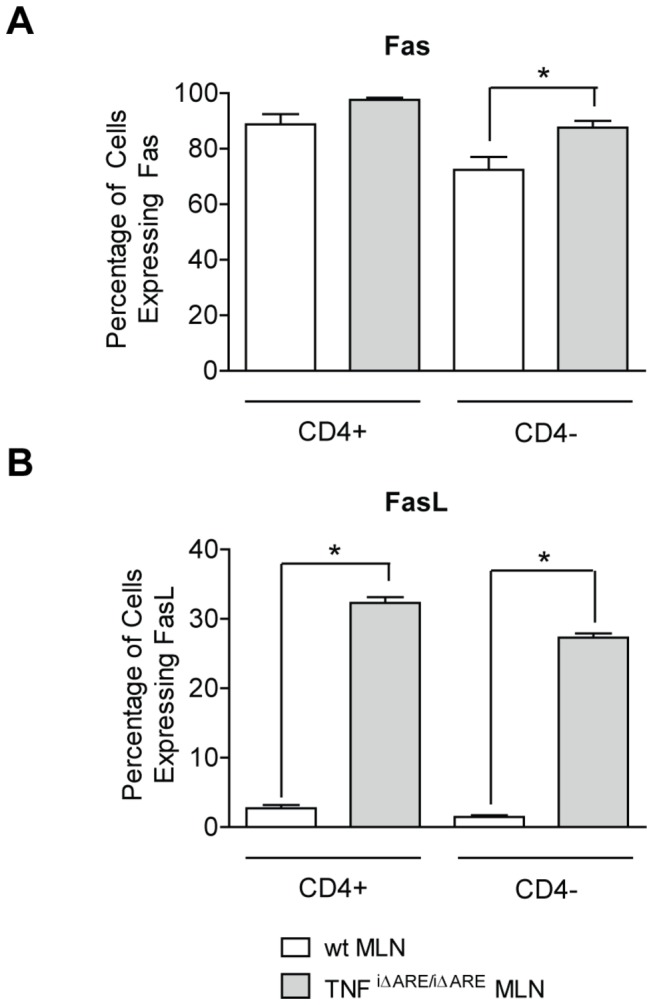
Increased apoptosis of lymphocytes in the MLNs of TNFi∆ARE/i∆ARE mice.Single cell suspensions were obtained from MLNs, and the expression of various surface markers was analyzed by flow cytometry. Fluorochrome-tagged monoclonal antibodies against CD4, Fas, and FasL were utilized for identification of the respective populations. Multiple color flow cytometry was performed on a FACS calibur system to determine the percentage of cells expressing surface markers and the intensity of expression. The vast majority of MLN cells stained positive for Fas and no significant differences detected between wt and TNFi∆ARE/i∆ARE mice. Conversely, expression of FasL was significantly elevated in MLN cells from TNFi∆ARE/i∆ARE mice as compared to wt controls. This difference remained significant when expression of FasL was examined separately in the CD4+ or CD4- populations. Mice were processed individually. Three separate experiments with 3-4 mice per group gave similar results, and one representative experiment is shown. Graphs represent mean values ± SEM for each group of experimental mice. *P<0.05, ** < P<0.01, *P<0.001.